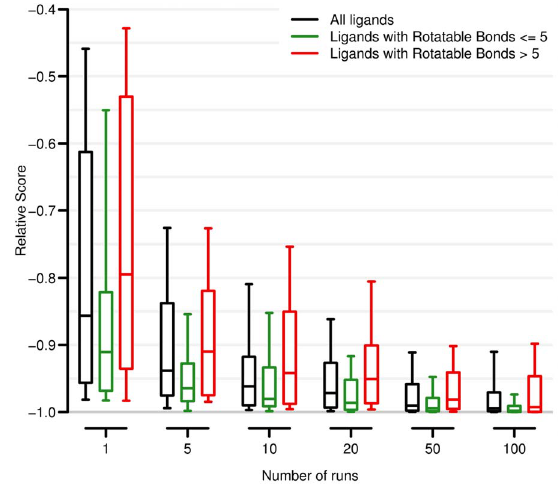
Figure 1. Relative score vs. the number of docking runs for all the protein-ligand complexes in the CCDC-Astex set. The boxplot indicates the median value (out of 1000 possible solutions) and the first and last quartile, while the whiskers span the 10% to 90% range. The whole set (black) has been sub-divided into ligands with 5 or fewer rotatable bonds (green) and the rest (red).